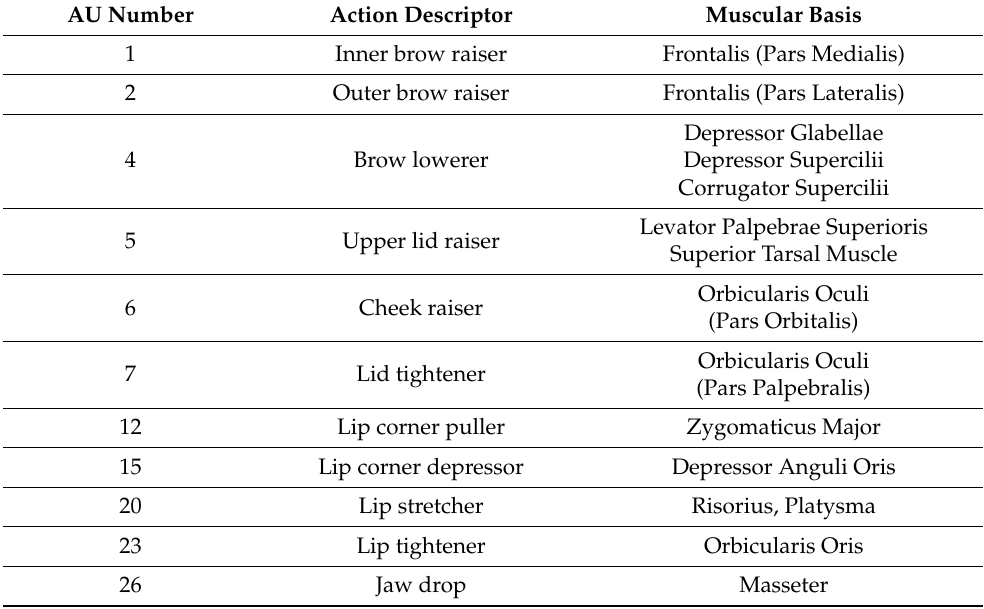
Table 3. List of FACS action units, relative action descriptors, and underlying facial muscles [40], of the expressions considered in the facial expression categorization